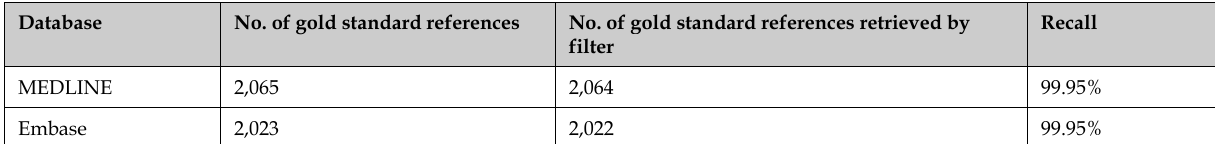
Table 1 Validation of the MEDLINE and Embase OECD countr ies’ filters